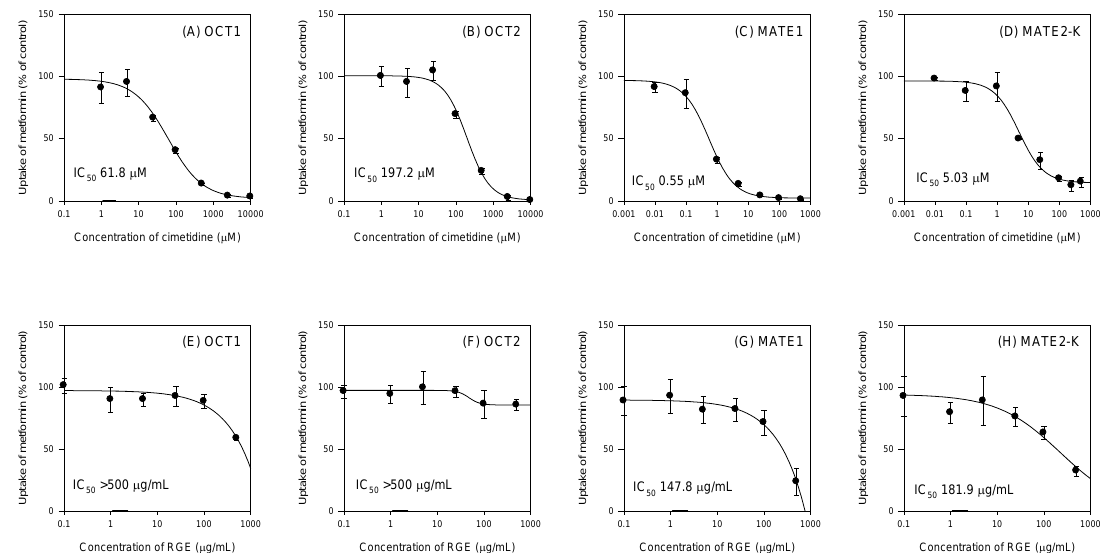
4.8 µ M for MATE2-K) [33,34].